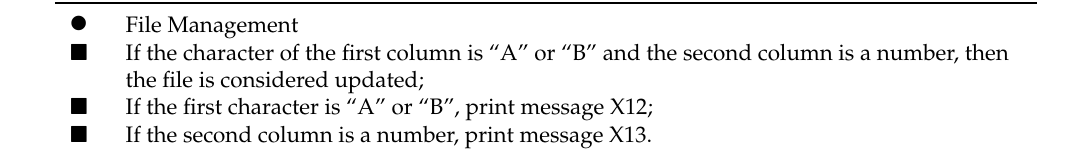
Table 6. One example of requirements by Myers [2].